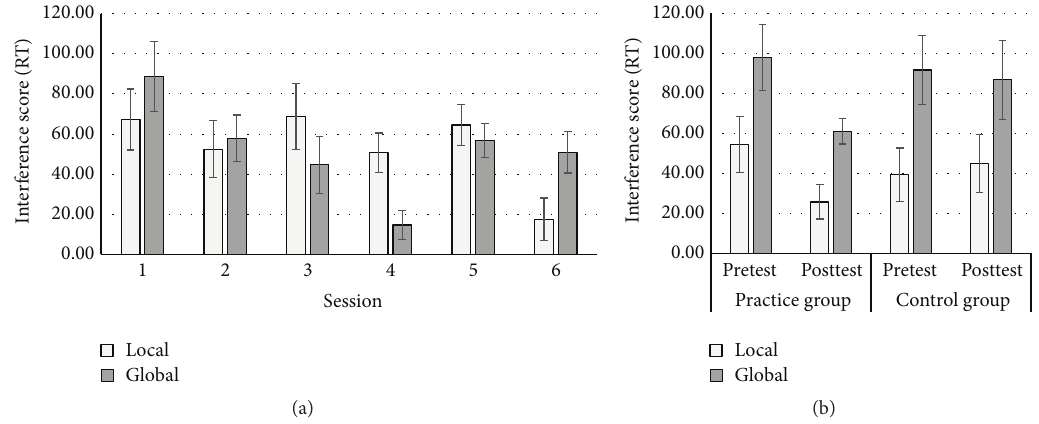
Figure 1: Practice effect (a) and transfer effect (b) of the Local-Global Task. Practice effect refers to the performance improvement (i.e., reduced RT interference scores) across six practice sessions. Transfer effect was indexed by the performance improvement from pretest to posttest in the practice group, but not the control group. Error bars represent the standard